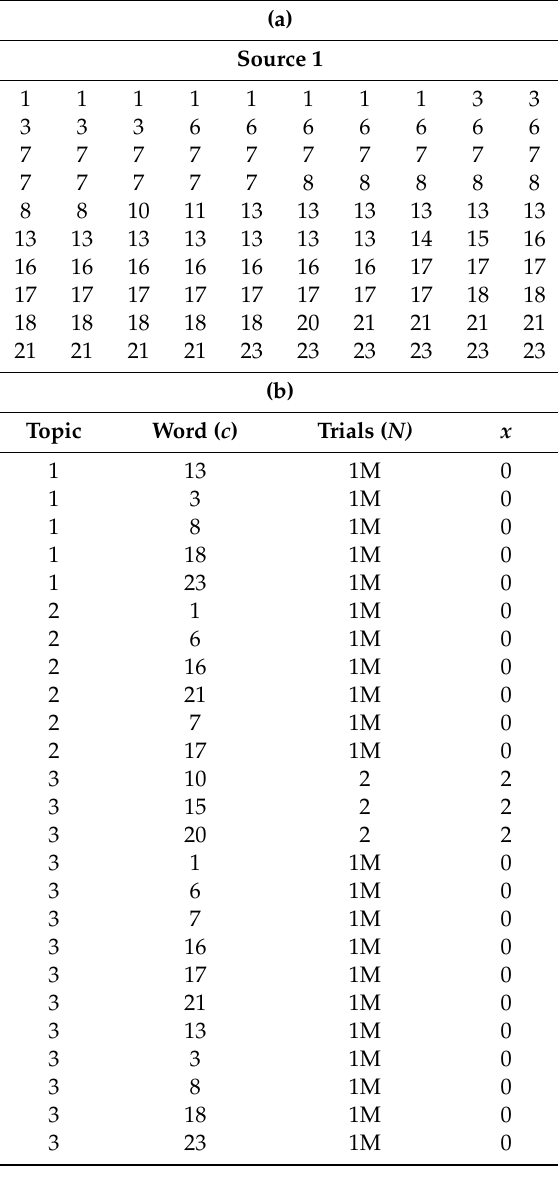
Table 1. ( a ) Data for the first low-level image; ( b ) 25 high-level data points with zaps with one million (M) e ff ective trials and